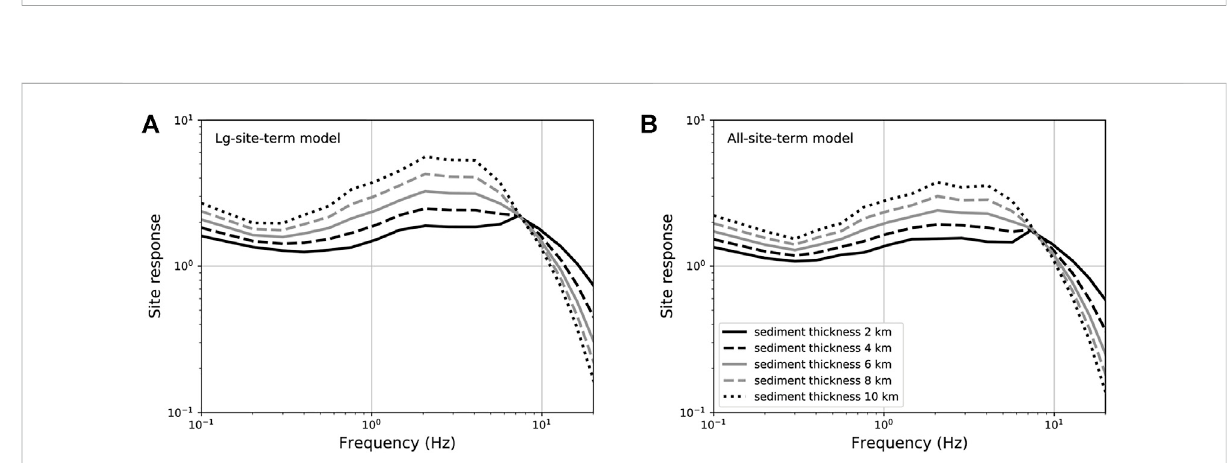
FIGURE 9 Site responses calculated using Eqs 9, 11 for sites in the Sichuan Basin with different sediment